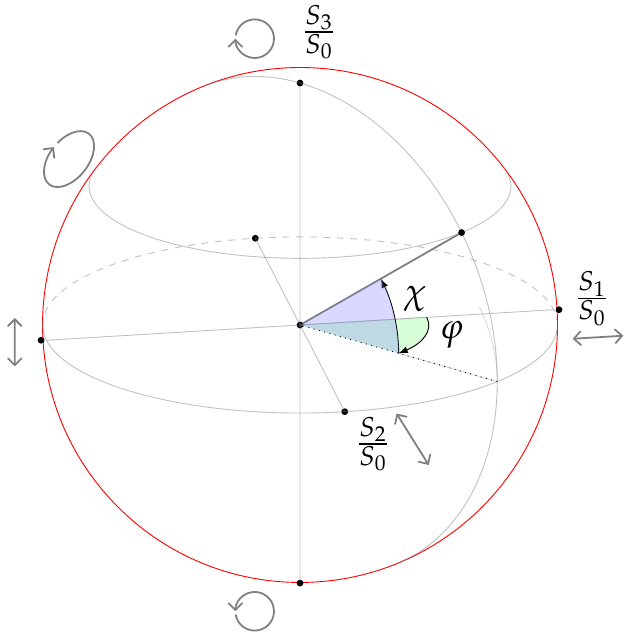
Figure 4. Observable Poincaré sphere of polarization states. Associated with any point on the sphere is a unique polarization state described either by spherical angular coordinates ( ϕ , χ ) or normalized Stokes parameters S 1 / S 0 , S 2 / S 0 and S 3 / S 0 .